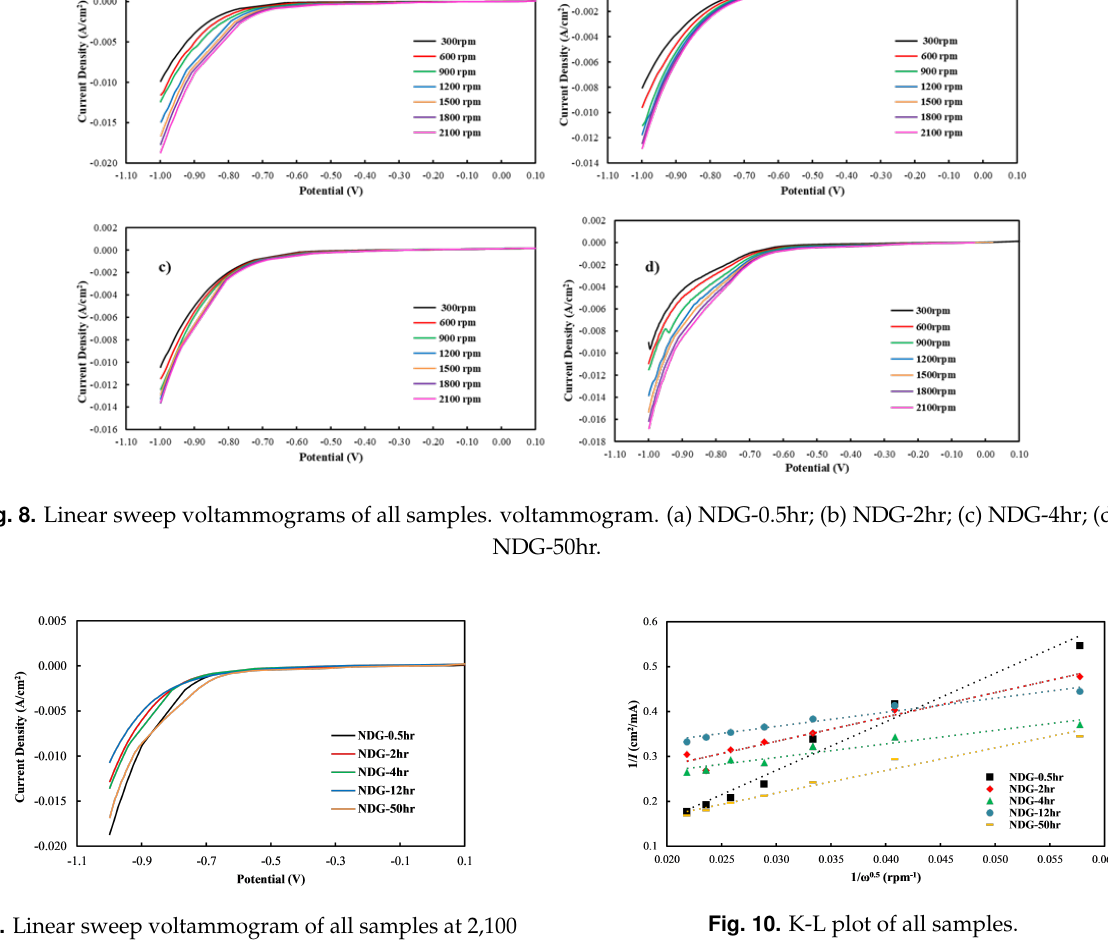
Fig. 9. Linear sweep voltammogram of all samples at 2,100 RPM.